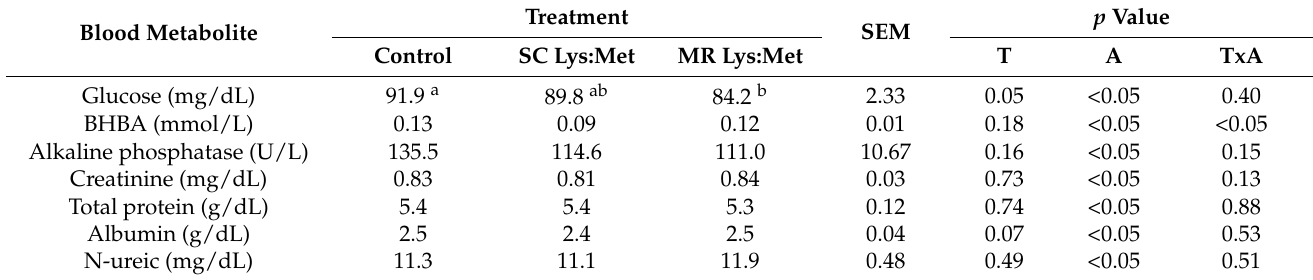
Table 4. Blood metabolites of dairy calves with or without lysine and methionine supplementation in starter or milk replacer. Blood